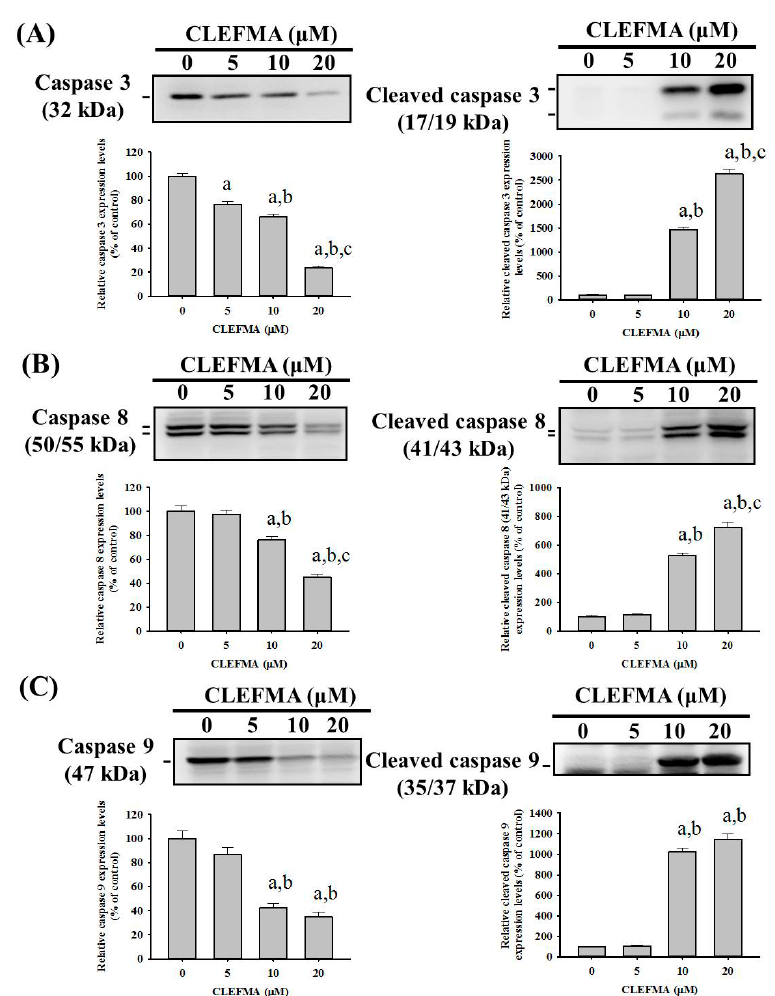
Figure 4. Effects of CLEFMA on the activation of caspases 3, 8 and 9 in U2OS cells. Western blot analysis for caspases 3, 8 and 9 and their active forms after various concentrations (5, 10 and 20 μ M) of CLEFMA treatment for 24 h in U2OS cells were measured as described in the Materials and Methods. Subsequently, ( A ) caspase 3 and cleaved caspase 3, ( B ) caspase 8 and cleaved caspase 8, and ( C ) caspase 9 and cleaved caspase 9 were subjected to quantitative analysis. Results are shown as mean ± S.D.; n = 3. ANOVA analysis with Turkey’s posteriori comparison was used. Caspase 3: F =